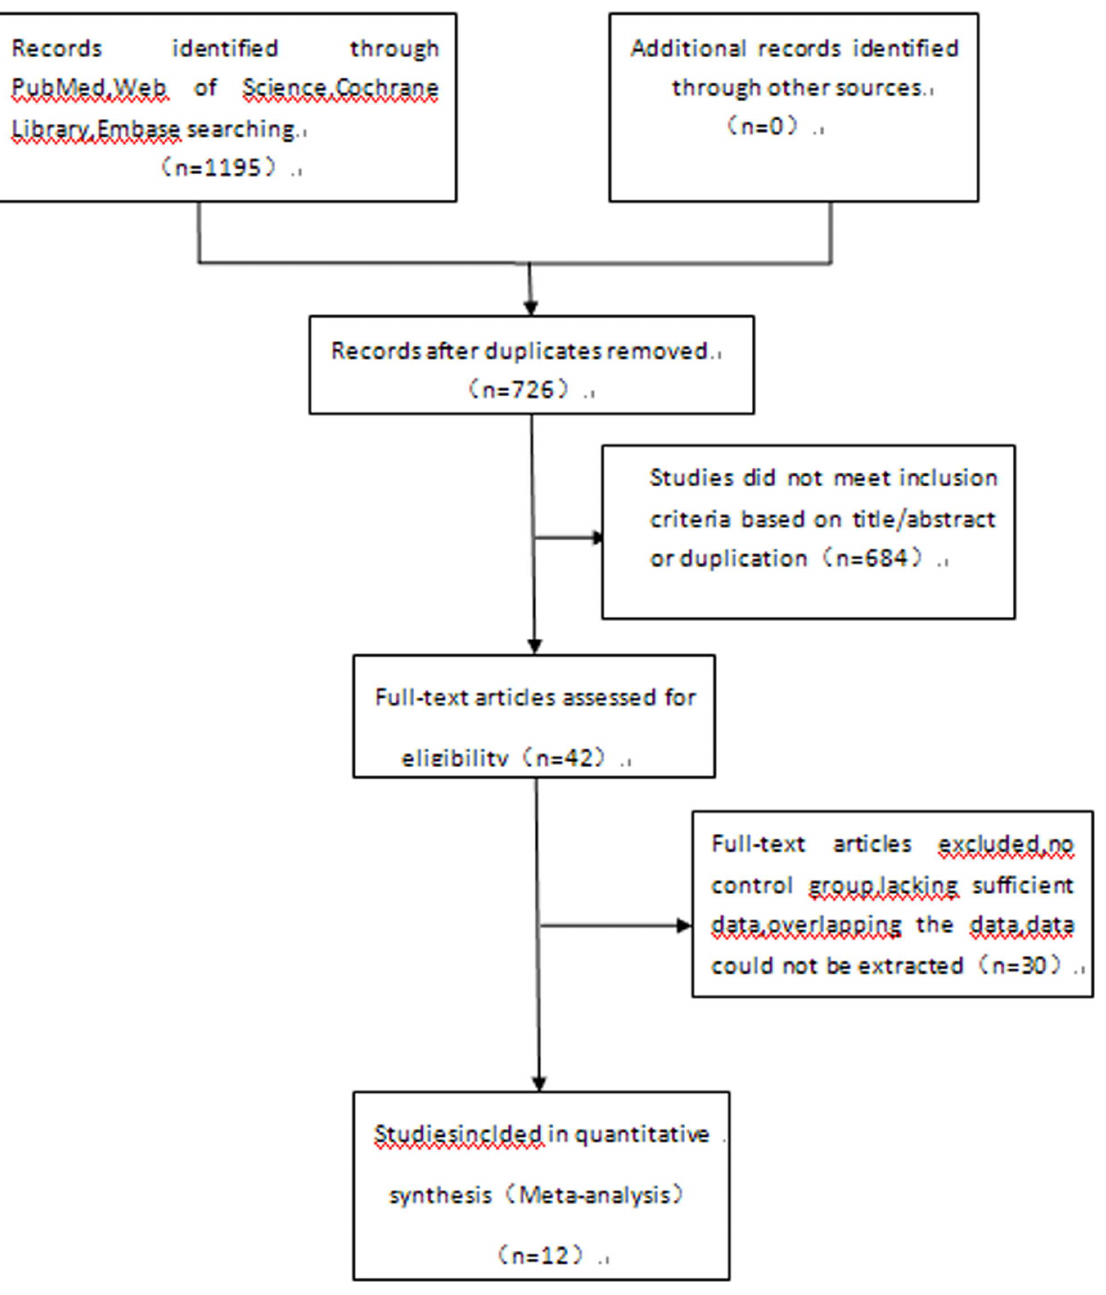
Fig 1. Flow diagram of the study selection